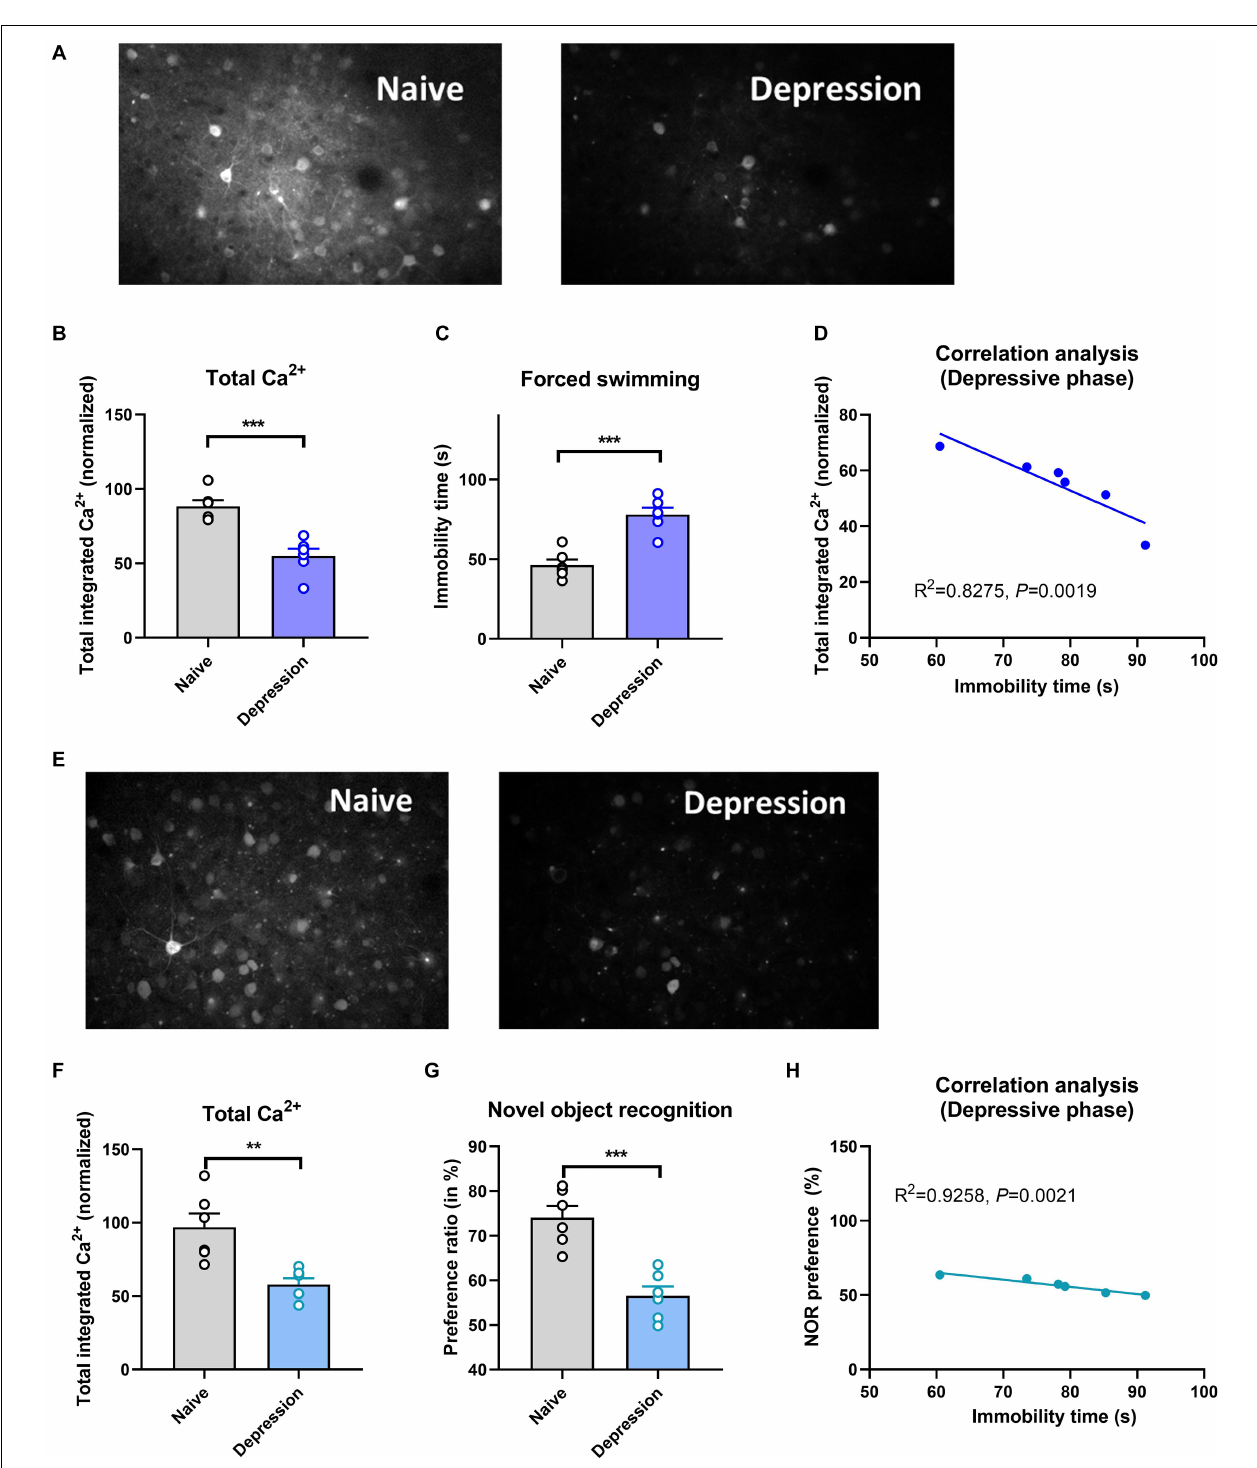
FIGURE 1 | Brain Ca 2+ activity and behavioral index alterations in mice with BPD exposed to CUMS and controls. Note : Compared with the naïve group (six mice, group-housed), mice in the depressive phase ( n = 6, group-housed) showed significantly decreased normalized integrated Ca 2+ activity (96.28 ± 11.17 vs. 53.00 ± 8.25, P < 0.001, A,B ) and more immobility time (86.52 ± 9.22 vs. 47.67 ± 5.31, C ), and these variables correlated with each other (D) ; mice in the depressive phase also showed Ca 2+ hypoactivity in the prefrontal cortex (E,F) , and had poorer novel object recognition preference ratios (G) . The preference ratio (pre-pause index) also correlated with the immobility time (H) . ** P < 0.01; *** P < 0.001, vs. the naïve group.